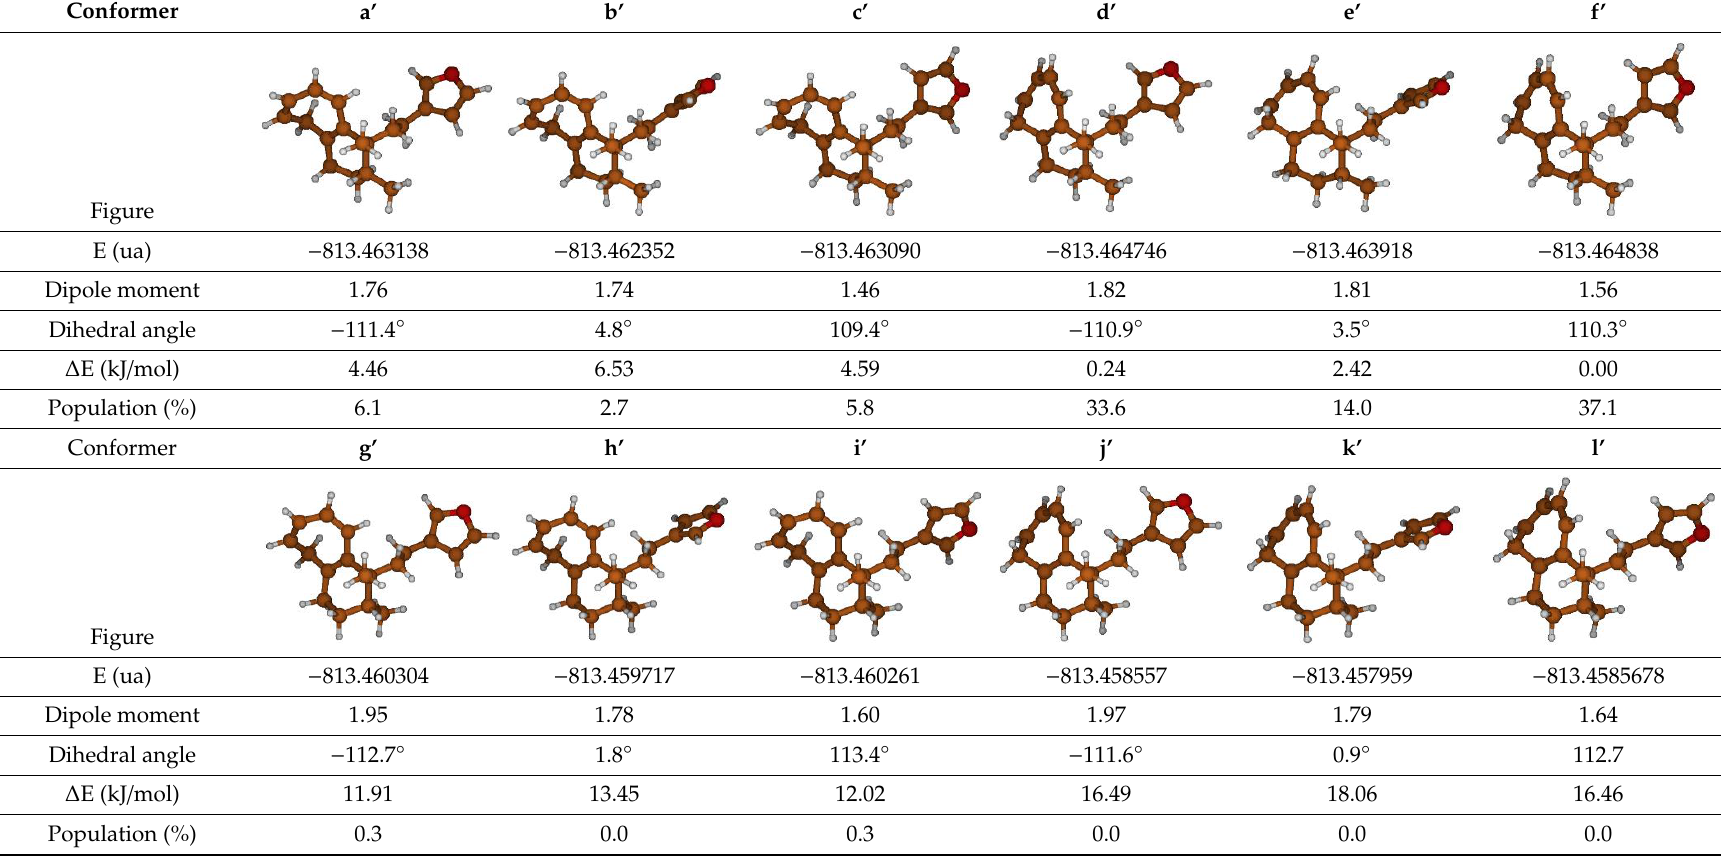
Table 4. Calculated B3LYP/6-311+G(d,p) Energies a , Dipole moments (Debye), relatives Energies a , (C13-C14-C15-C18) dihedral angle, equilibrium population at 25°C and figures of conformations a-l of the 8 R , 9 R isomer of dodovisate C ( 1 ).